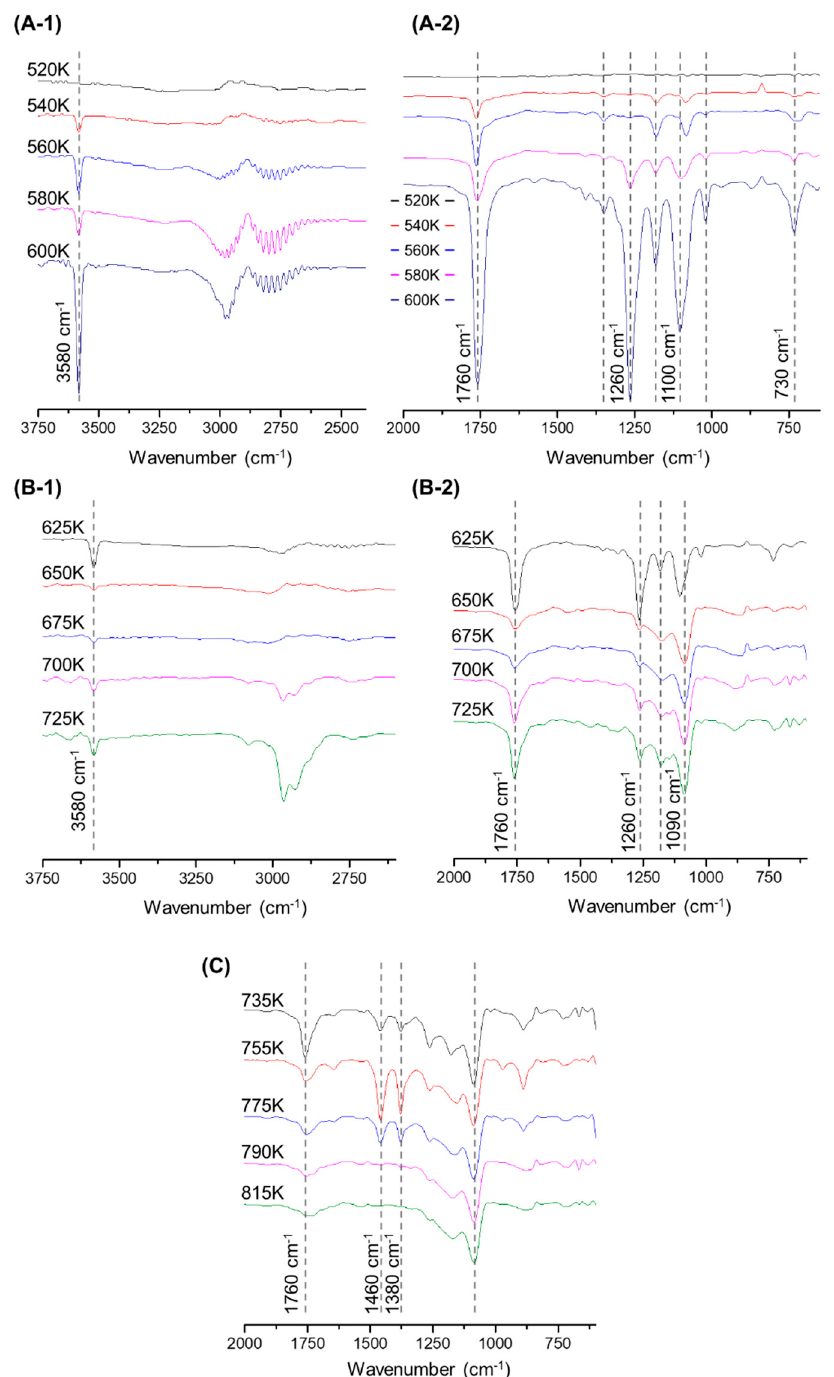
Figure 7. TG-FTIR spectrum drift by temperature during MP pyrolysis: ( A-1 ) 3750–2400 cm − 1 , in